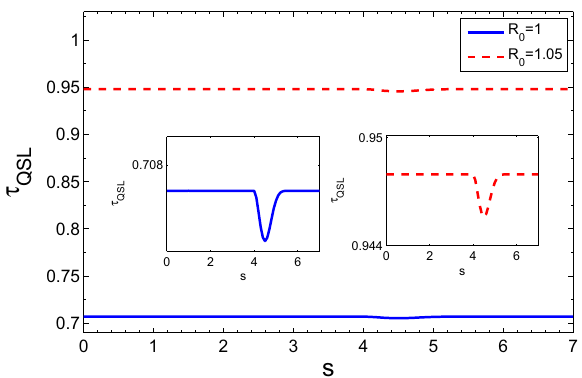
Fig. 9 TheQSL-timefortheOhmic-likedephasingmodelasafunction of the Ohmicity parameter s . The value of driving time is τ D = 1, initial time is τ = 0 and Ω = 10